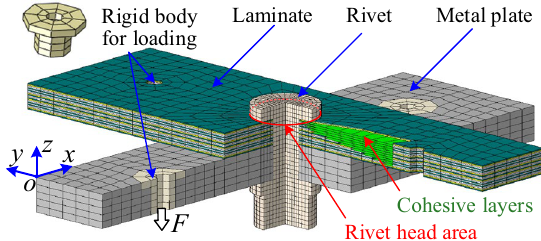
Figure 4 Finite element model of composite/aluminum riveted